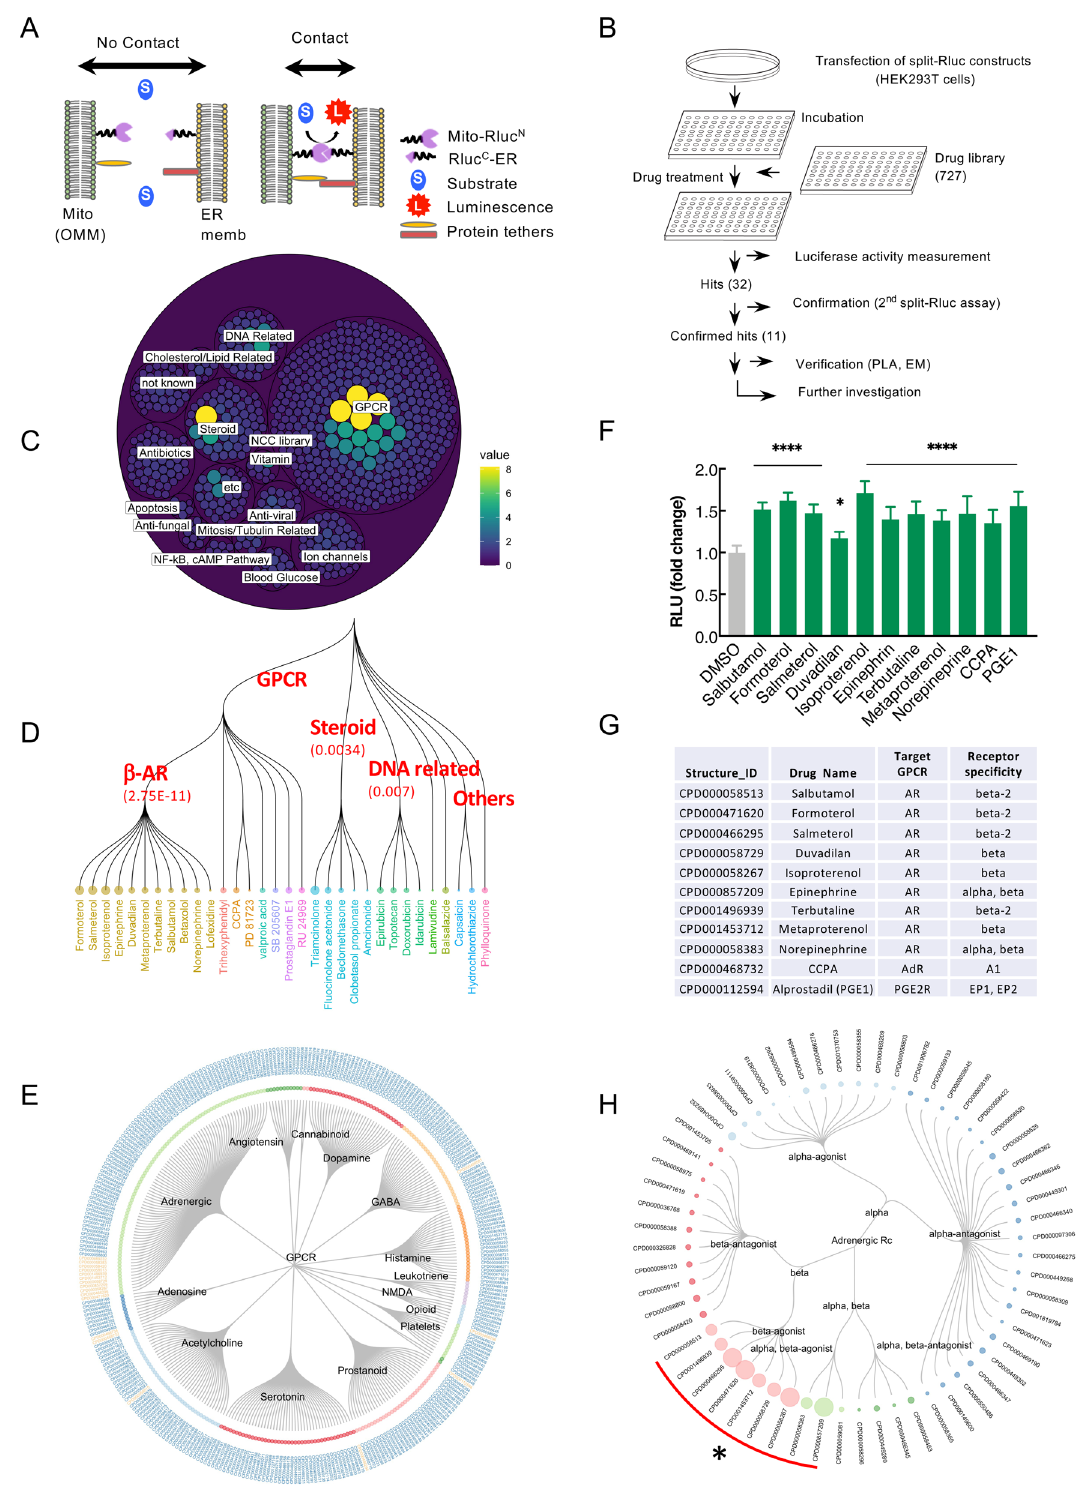
Figure 1. Compound library screening with split-Rluc assay identifies GPCR agonists. ( A ) S chematic of split-Rluc assay. ( B ) S chematic of screen workflow. ( C ) Initial screen results depicted with circular packaging dendrogram (each circle: each drug; circle size: normalized drug activity). Green to yellow circles indicate 32 hits. ( D ) Dendrogram of 32 initial hits. Circle size: normalized drug activity. Numbers in the parenthesis: false discovery rate (adjusted p values). ( E ) Circular dendrogram of all GPCR-associated drugs grouped into each pathway (Drug IDs with orange color: 18 hits). ( F ) Repeated split-Rluc assay in HEK293T cells treated with 11 hits targeting GPCRs. RLU (relative light unit): normalized luciferase activity (to the mean of DMSO). n = 3 experiments; 1-way ANOVA with Dunnett’s multiple comparisons test; * p = 0.0135; **** p < 0.0001. ( G ) List of 11 confirmed hits targeting GPCRs. AR adrenergic receptor, AdR adenosine receptor, CCPA 2-chloro-N 6 cyclopentyladenosine, PGE1 prostaglandin E1, PGE2R PGE2 receptor. ( H ) Circular dendrogram of all AR-associated drugs grouped based on target specificity. Circle size: normalized drug activity; circle color: target specificity; red curve with asterisk (*): 9 hits targeting